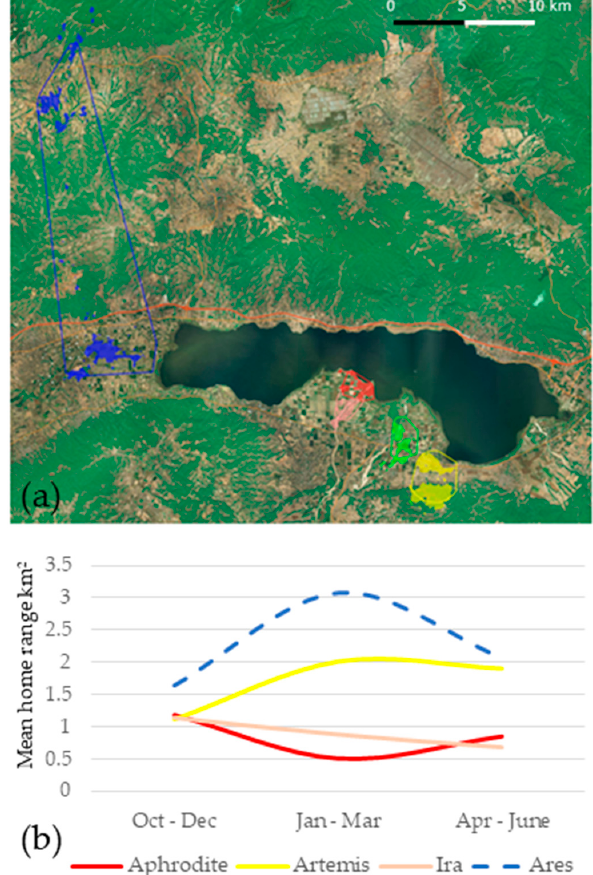
Figure 5. ( a ) Minimum convex polygon (solid line) and brownian bridge (filled area) home ranges (95%) of the five GPS-collar fitted wildcats (male: Ares, Apollo; female: Aphrodite, Ira, Artemis) for the duration of the study period. [Background: Bing Satellite Image overlayed by green layer depicting forests and hedges] ( b ) Temporal variation of brownian bridge home range size of the four wildcats (Apollo is excluded as available data covered only Oct–Dec).